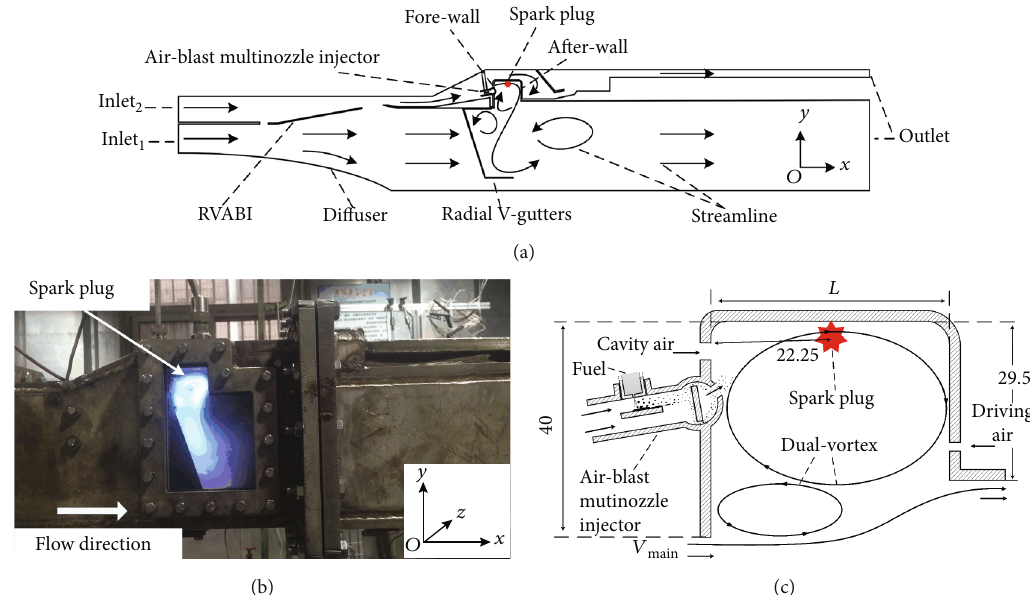
Figure 1: A 2-D schematic and a photograph of augmentor at the center section: (a) schematic of the augmentor, (b) a photograph of augmentor, and (c) schematic of the injector and the position of spark plug at a 20mm section far from the center section. All dimensions in mm.